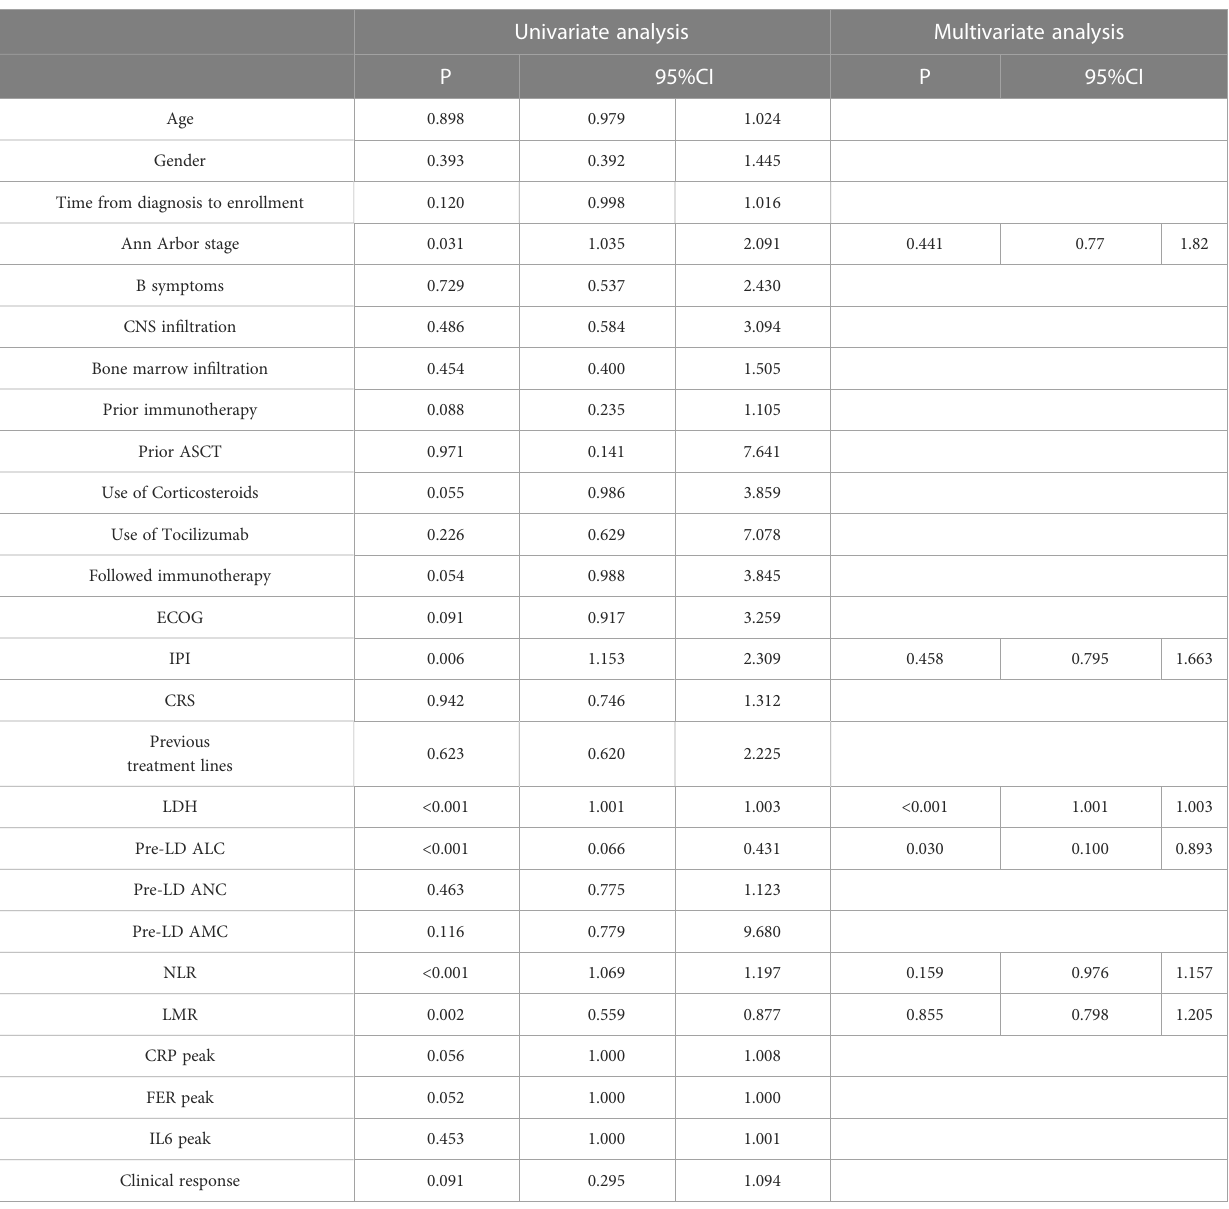
TABLE 4 Univariate and multivariate analysis of